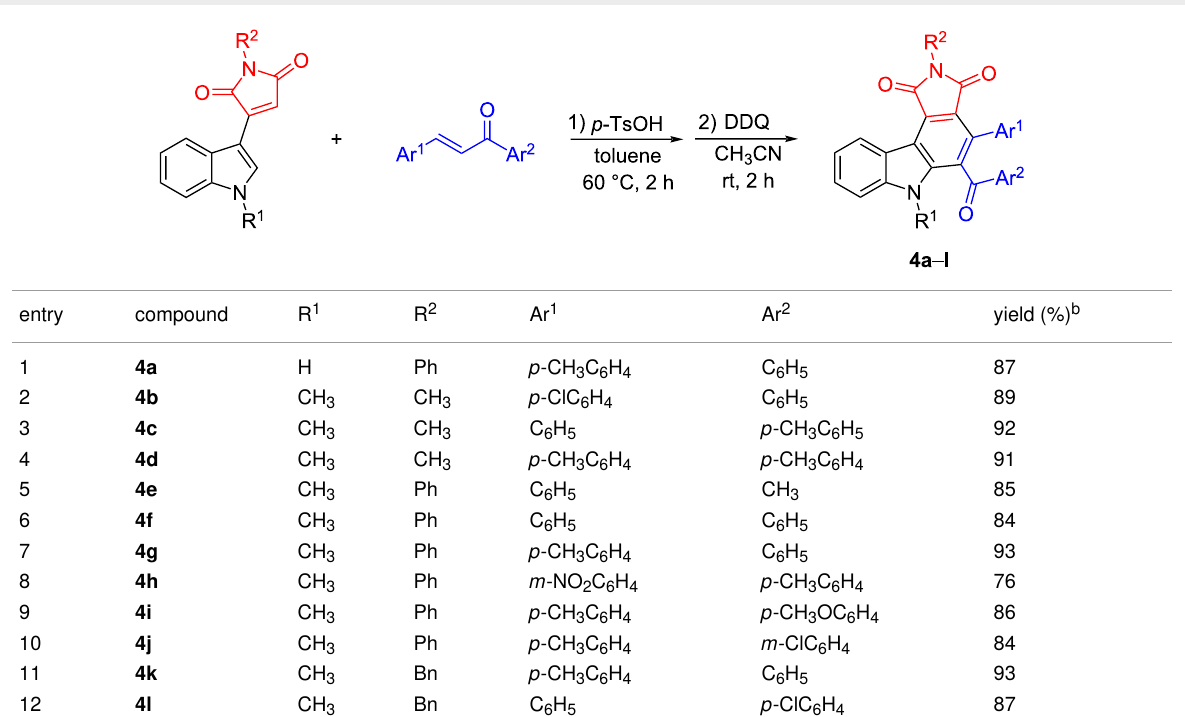
separate. After oxidation with DDQ, the aromatized carbazole derivatives 6a – n were easily obtained as single products in good yields. The chemical structures of the carbazoles were fully characterized by 1 H NMR, 13 C NMR, IR, and HRMS